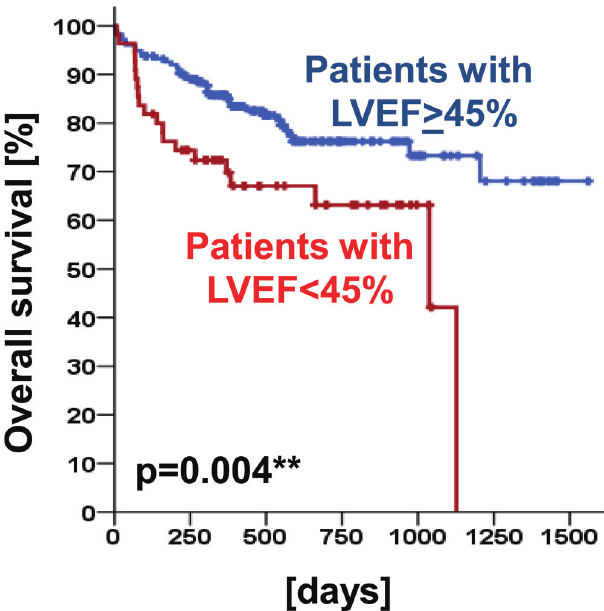
Fig 4. Prognostic impact of left ventricular ejection fraction (LVEF) in the full study collective (p = 0.004). Overall survival of those patients with a LVEF (cid:1) 45% was increased compared to those patients with a LVEF <